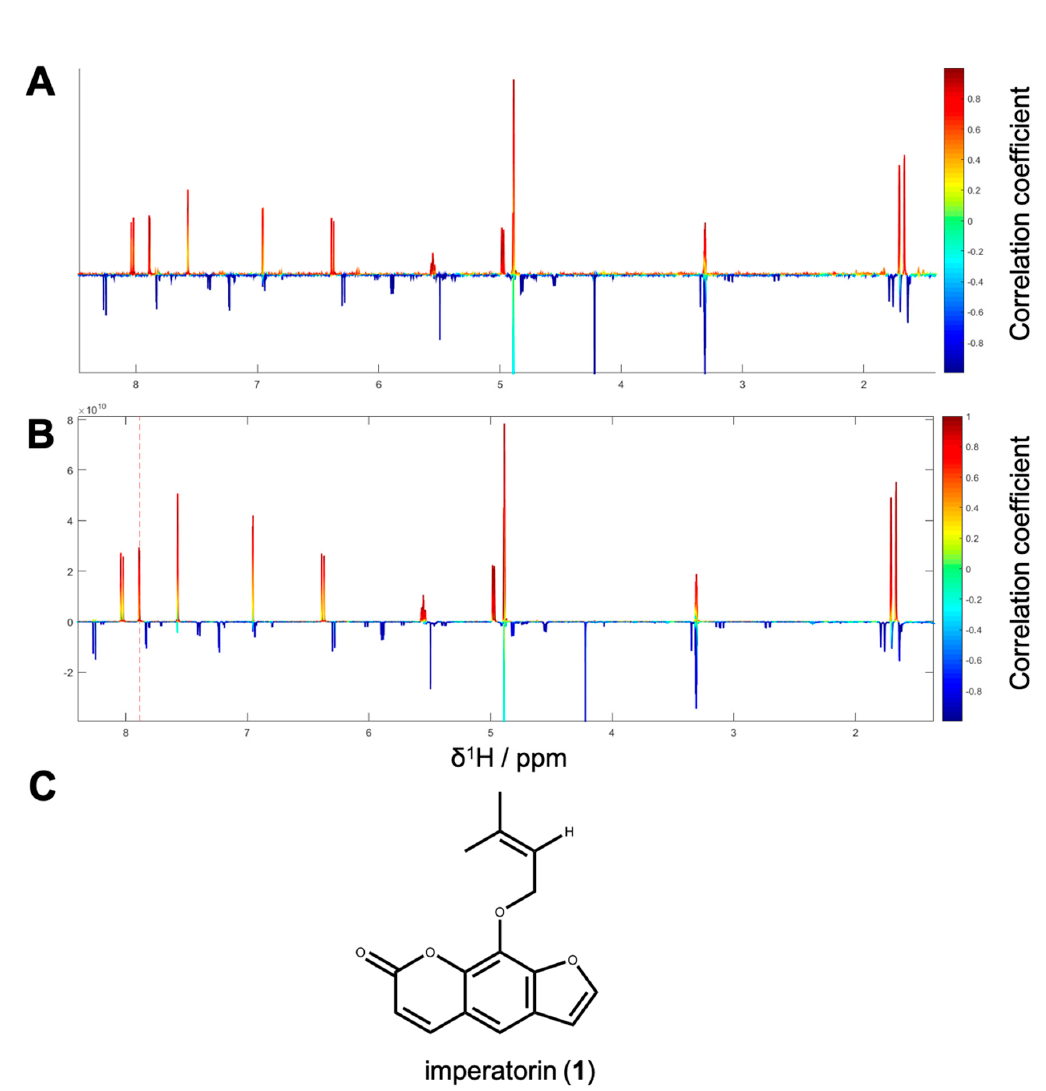
Figure 3. ( A ) HetCA plot of package I. The color code is based on the correlation coefficient: red signals (“hot features”) are positive, blue signals (“cold features”) are negatively correlated with bioactivity; ( B ) STOCSY plot of package I. The signal at δ H 7.88 was chosen to obtain the information which molecule(s) share this hot feature. The plot is color coded based on the correlation coefficient: red = signals belonging to molecule(s) that have a signal at δ H 7.88; blue = signals belong to molecule(s) that do not have the signal at δ H 7.88; ( C ) structure of the positively correlated and identified compound 1.